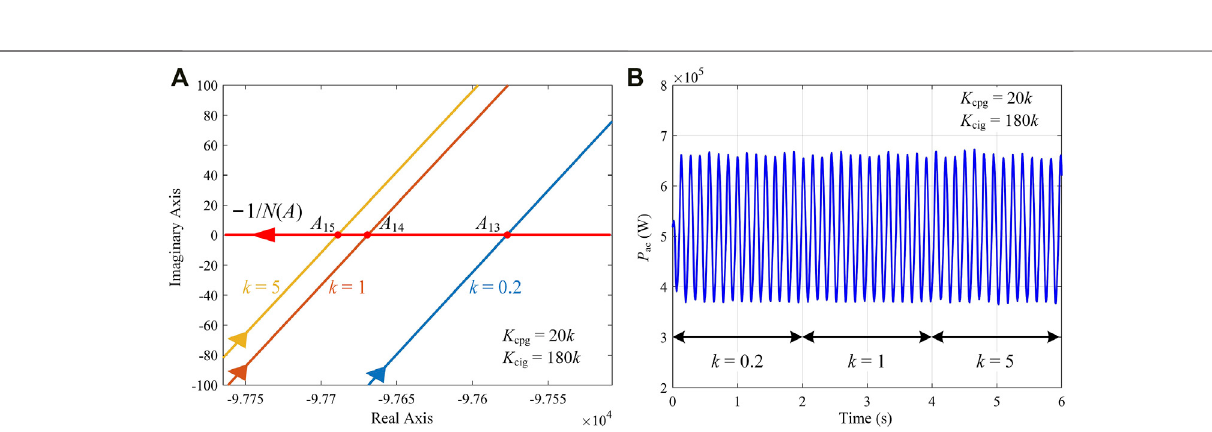
FIGURE 8 | Stability analyses and simulations when changing voltage-loop parameters K vp and K vi . (A) Stability analyses based on the DF method. (B) Power output.